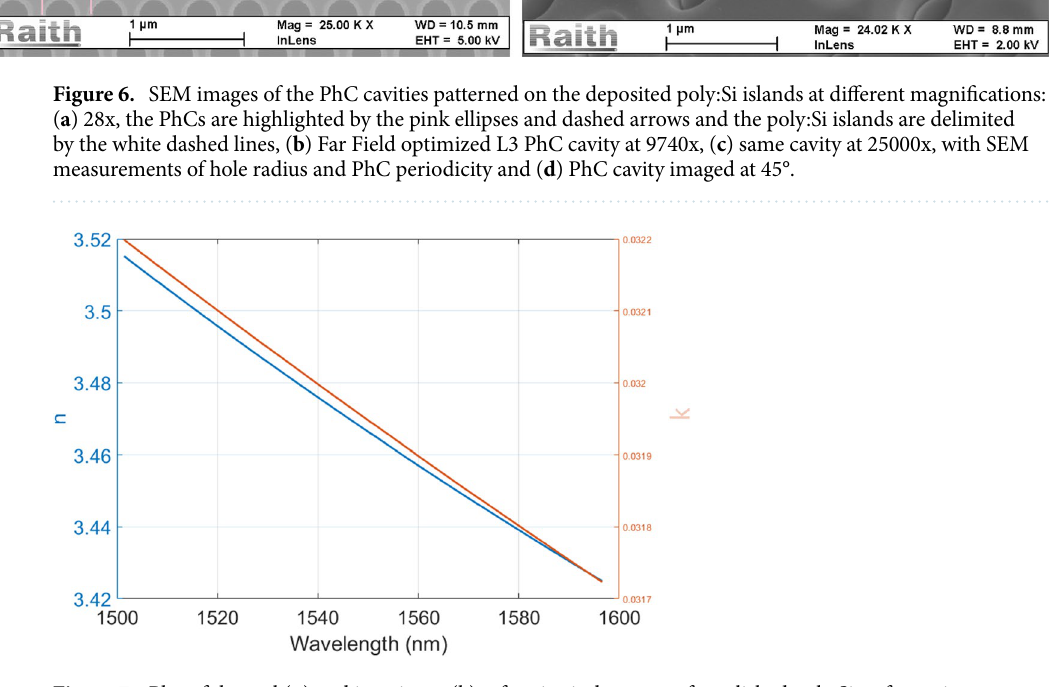
Figure 7. Plot of the real (n) and imaginary (k) refractive index parts of a polished poly:Si wafer against wavelength, measured with the ellipsometer and fitted with a Cauchy